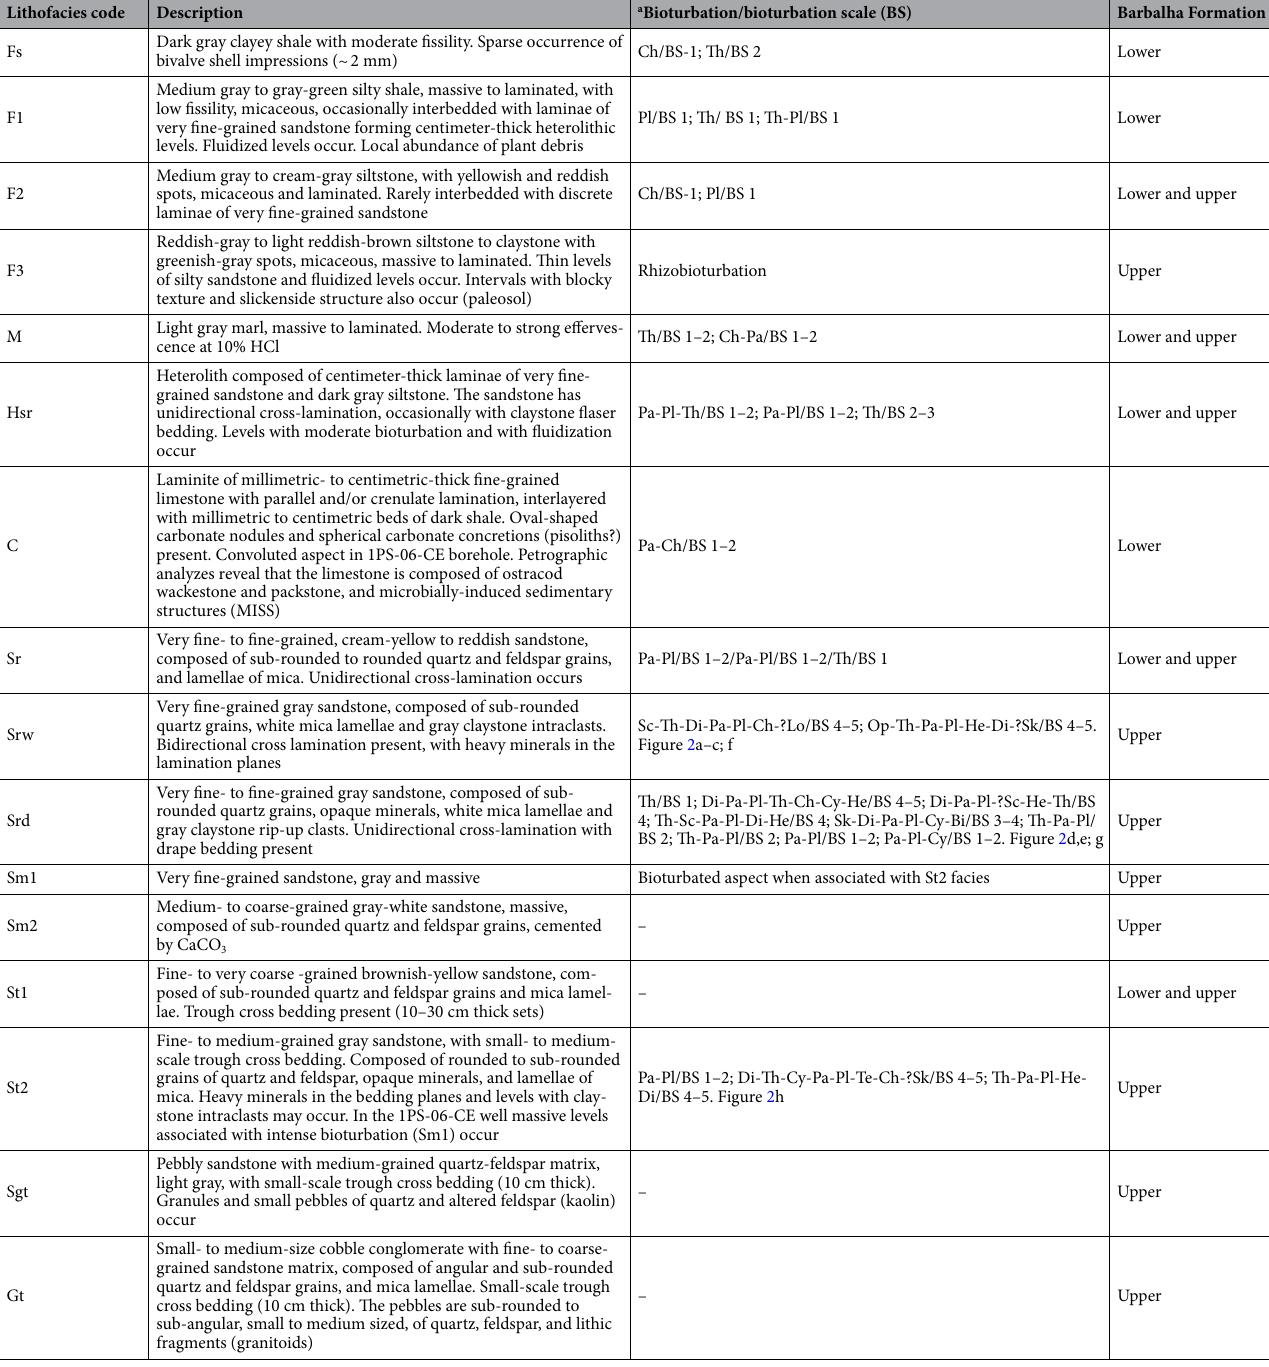
Table 1. Sedimentary lithofacies identified in the Barbalha Formation (upper and lower parts). a Ichnofossils: Ch, Chondrites isp.; Th, Thalassinoides isp.; Pl, Planolites isp.; Pa, Palaeophycus isp.; Di, Diplocraterion isp.; Cy, Cylindrichnus isp.; He, Helminthopsis isp.; Sc, Scolicia isp.; Op, Ophiomorpha isp.; Sk, Skolithos isp.; Te, Teichichnus isp.; Lo, Lockeia isp; Bi, bioturbation